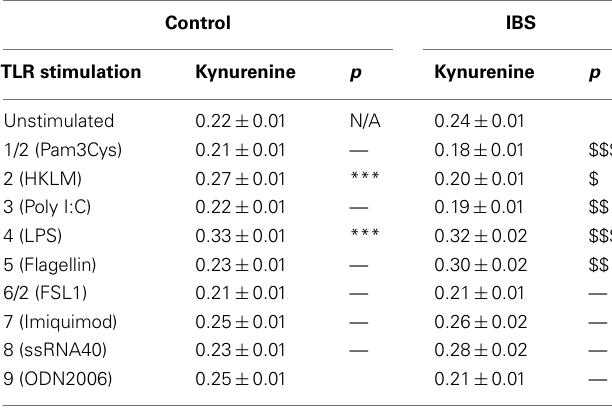
Table 1 |Tryptophan concentrations ( μ gmL − 1 ) in unstimulated and TLR agonist stimulated whole blood supernatants from healthy controls and IBS patients.